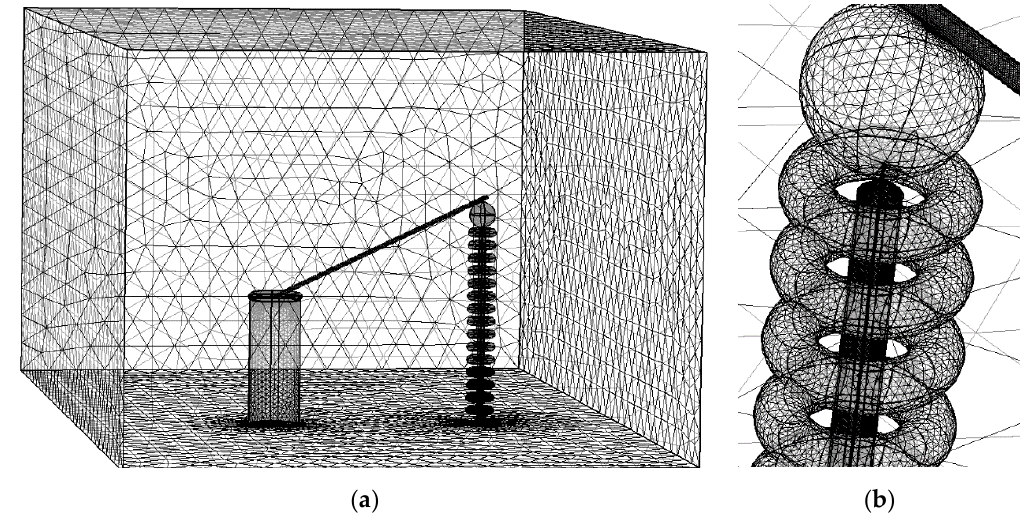
Figure 9. Grading rings added to the resistive high-voltage divider to minimize the effects of the stray capacitance. ( a ) Mesh of the full layout, including the high-voltage source, the divide, and the grading rings, ( b ) Detail of the aluminum grading rings.